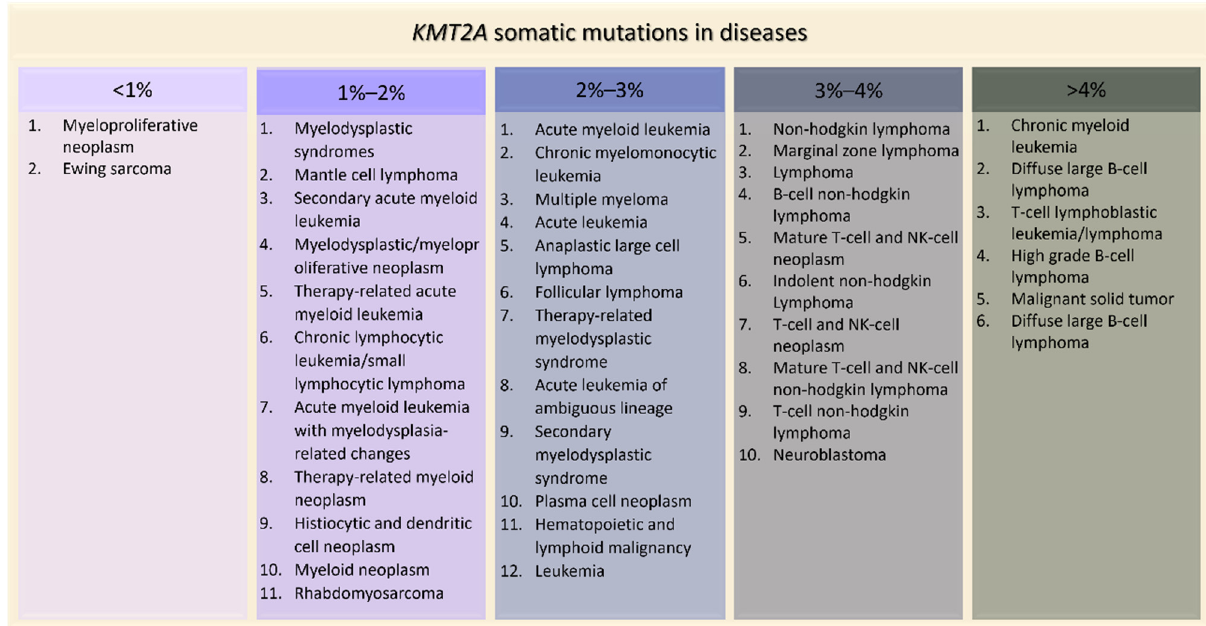
Figure 5. KMT2A somatic mutations in tumors ordered by percentage of positive cases (AACR Project